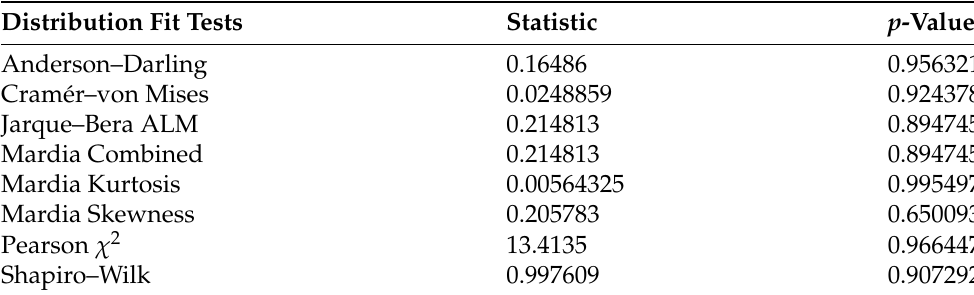
Table 6. Distribution fit tests for κ 44 .